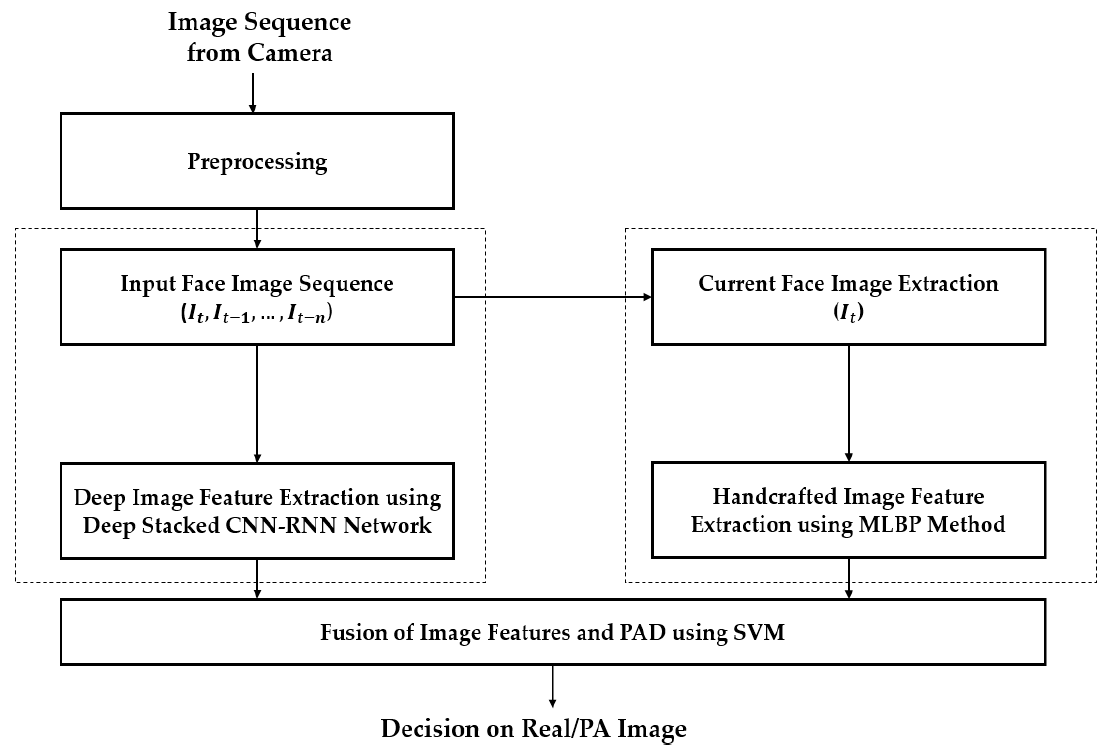
Figure 1. Working sequence of the proposed method for face-PAD.